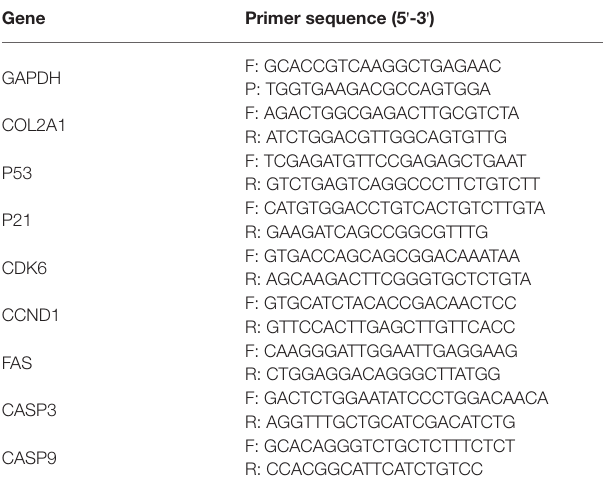
TABLE 1 | Gene-specific primers of qRT-PCR